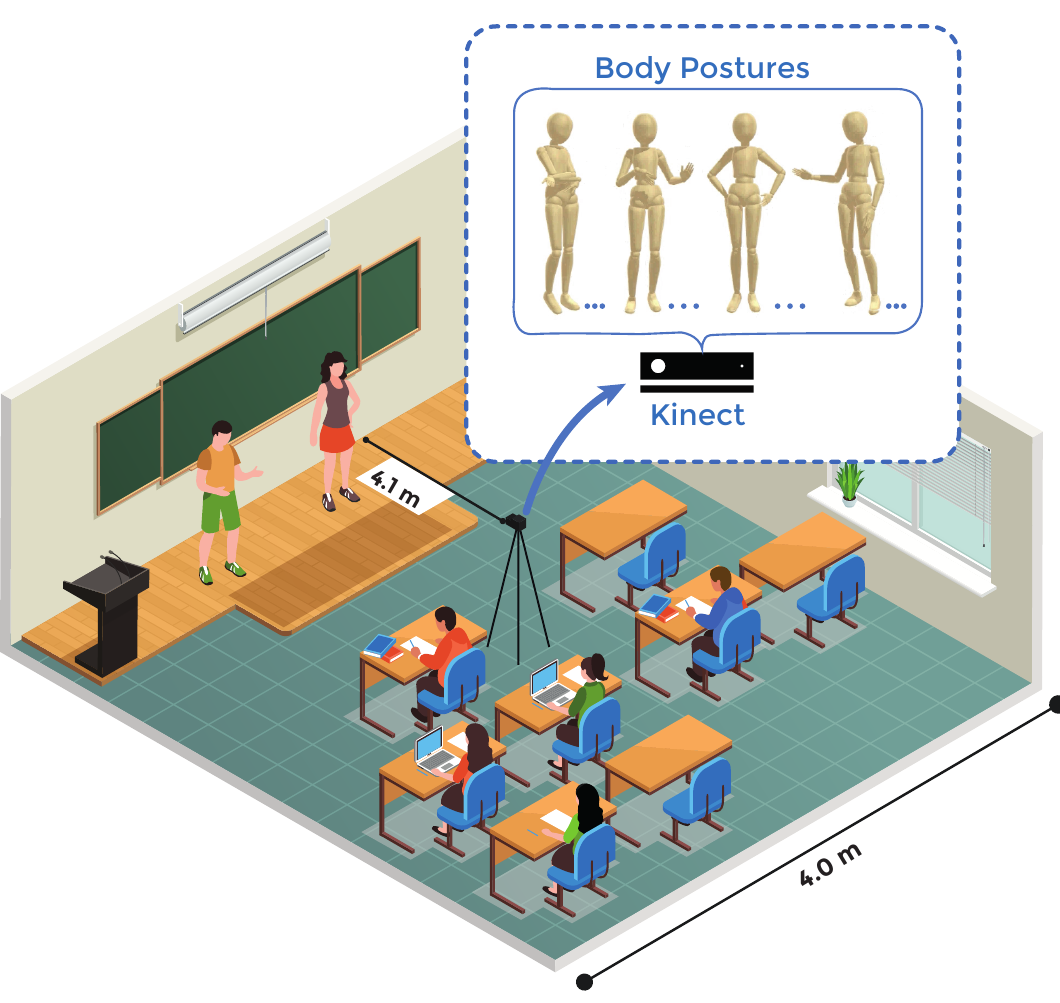
Figure 2. Setting